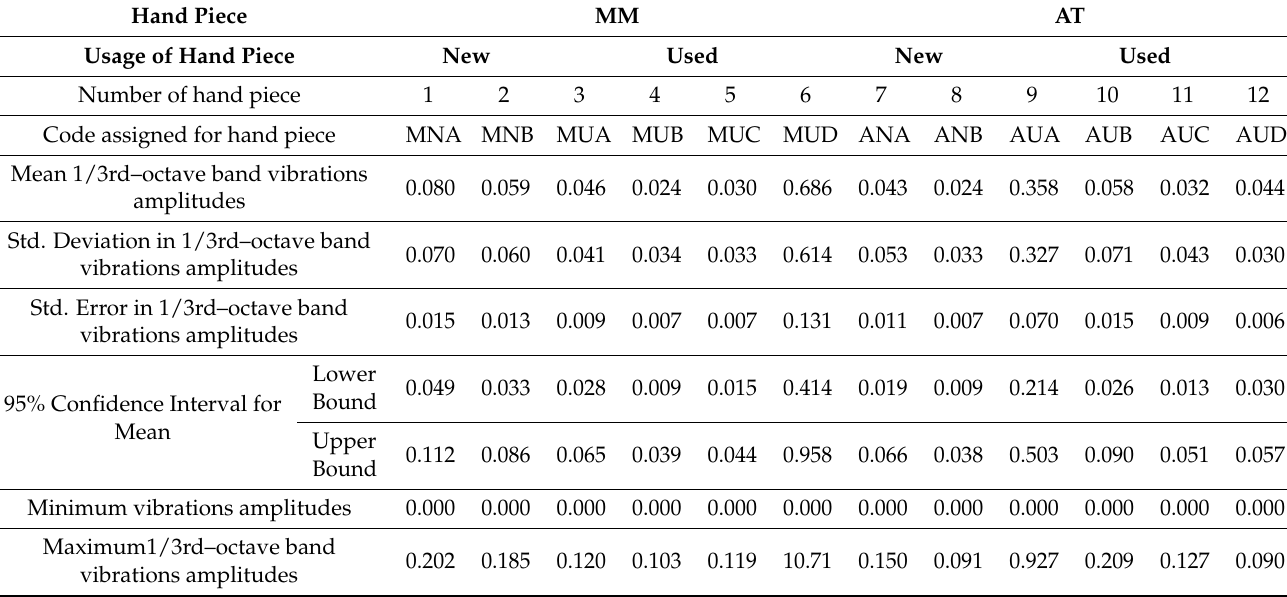
Table 2. Descriptive statistics for 1/3-octave band vibration amplitudes during